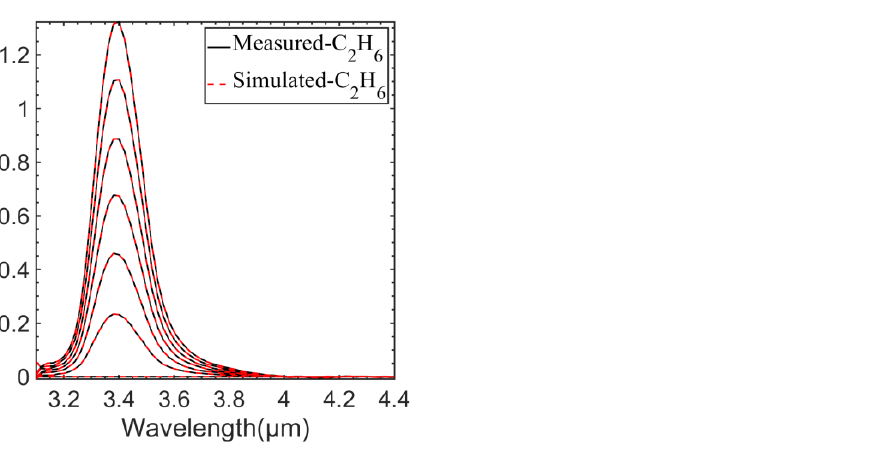
Figure 10. ( a ) Comparison of measured and simulated absorption spectra of 1824 ppm CH 4 . ( b ) Comparison of measured and simulated absorption spectra of CH 4 at different concentrations.